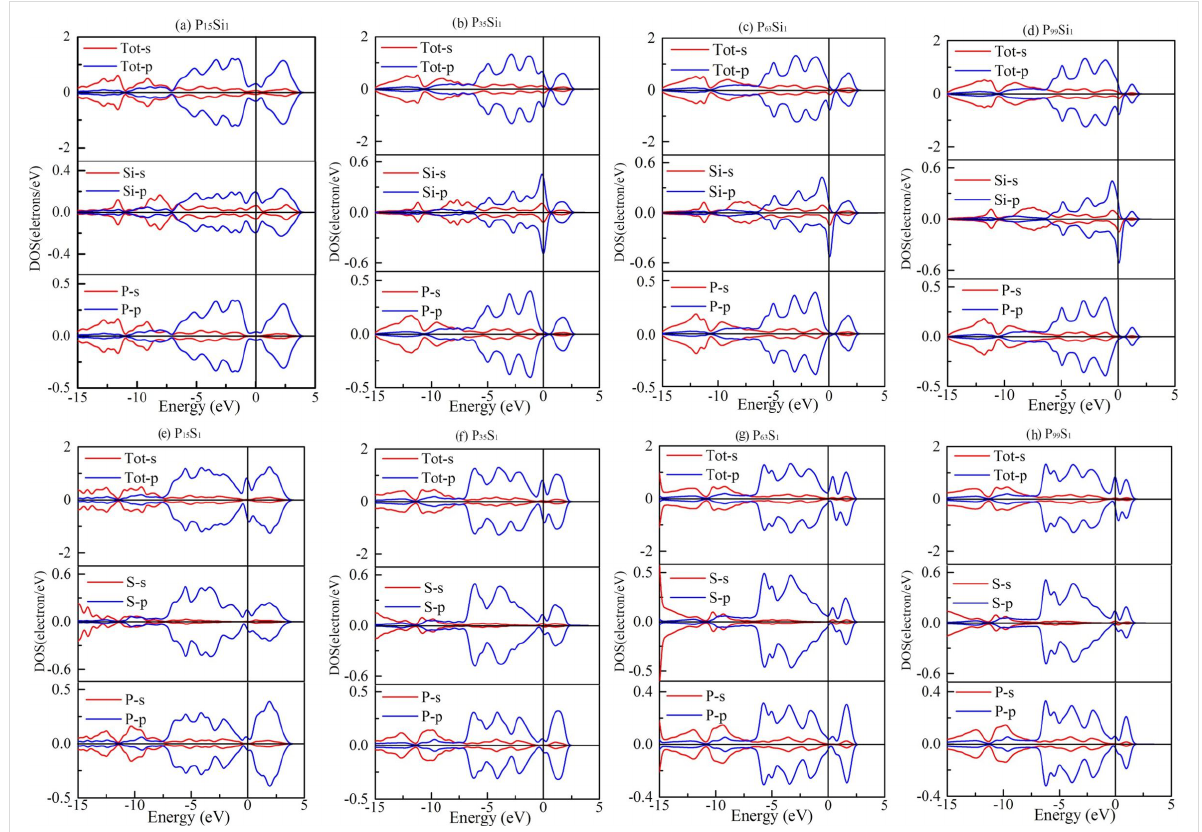
Figure 4: The partial density of states (PDOSs) of Si- and S-doped phosphorenes, Si and S atoms, and neighboring P atoms. (a–d) PDOSs of Si-doped phosphorene with (a) 2 × 2 × 1, (b) 3 × 3 × 1, (c) 4 × 4 × 1, and (d) 5 × 5 × 1 supercell, respectively; (e–h) PDOSs of the S-doped phospho- rene with (e) 2 × 2 × 1, (f) 3 × 3 × 1, (g) 4 × 4 × 1, and (h) 5 × 5 × 1 supercell, respectively. The Fermi level is also shifted to 0